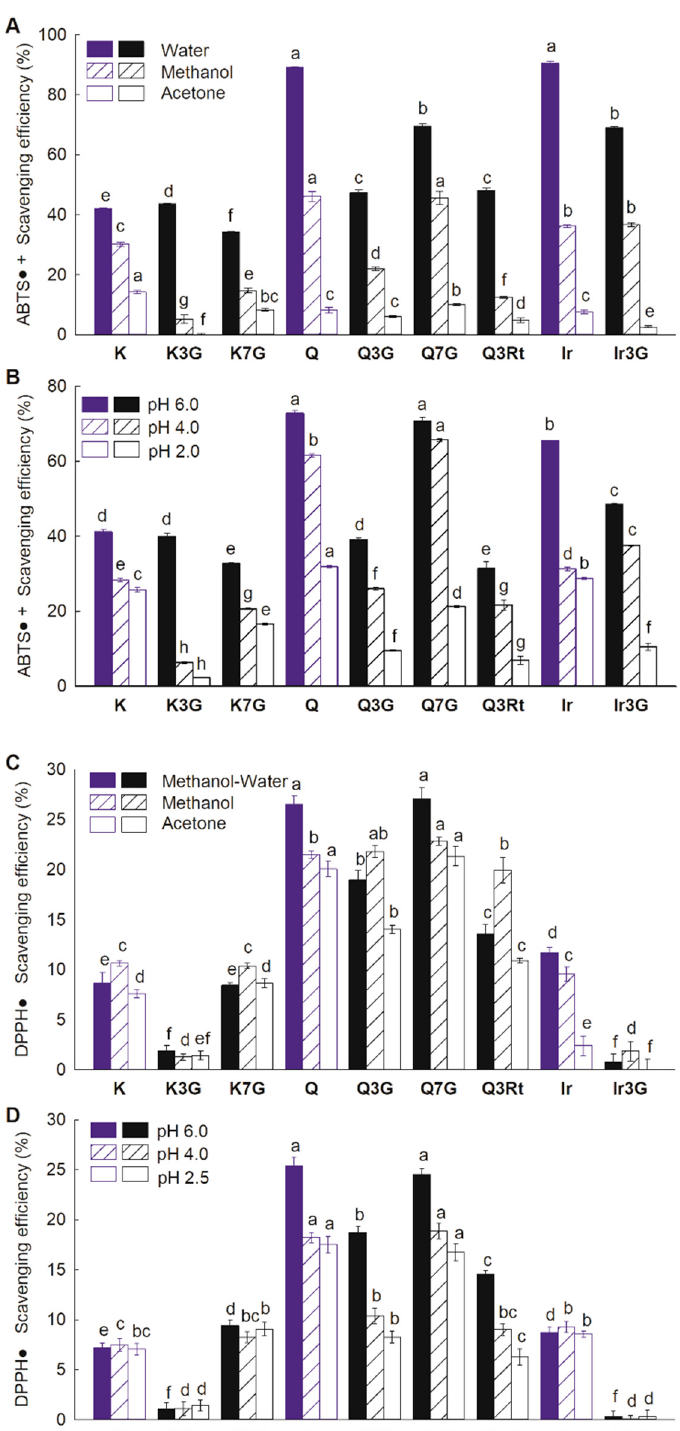
Figure 2. Antioxidant capacity of flavonols evaluated using 2,2 ′ -azino-bis(3-ethylbenzothiazoline-6-sulfonic acid) (ABTS) assay in different solvents ( A ) or in phosphate buffer (PBS) buffers with different pH ( B ) and evaluated using 2,2-diphenyl-1-picrylhydrazyl (DPPH) assays in different solvents ( C ) or in PBS buffers ( D ). Data are shown as mean ± SE ( n = 5). Names of the flavonol compounds are presented in Figure 1. The different small letters indicate significant differences ( p < 0.05) among compounds in the same solution or condition.